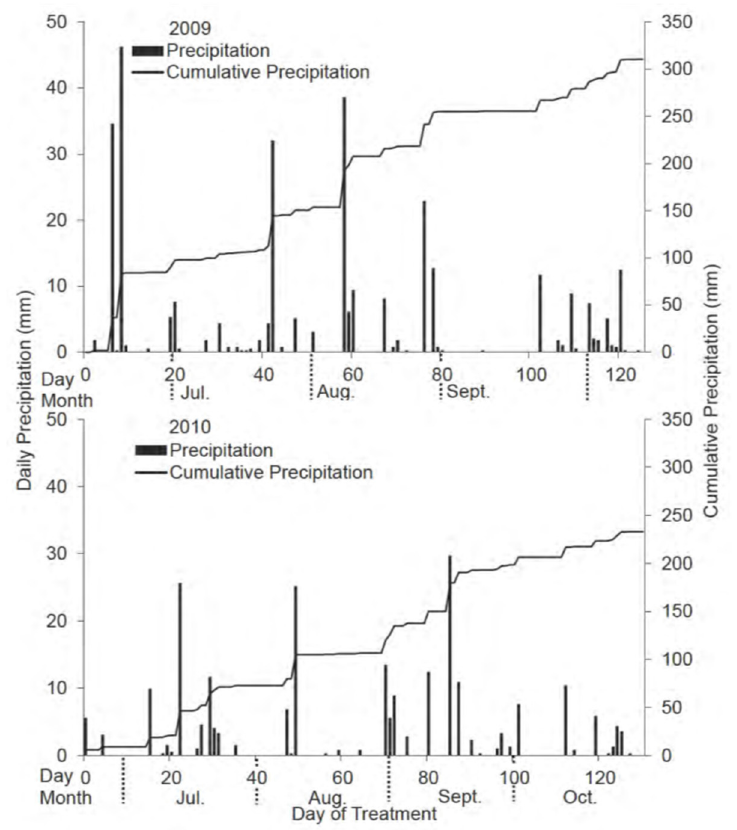
Figure 1. Daily (bars) and cumulative (line) precipitation from 11 June to 14 October (Day 126) 2009 and 23 June to 31 October 2010 (Day 131).